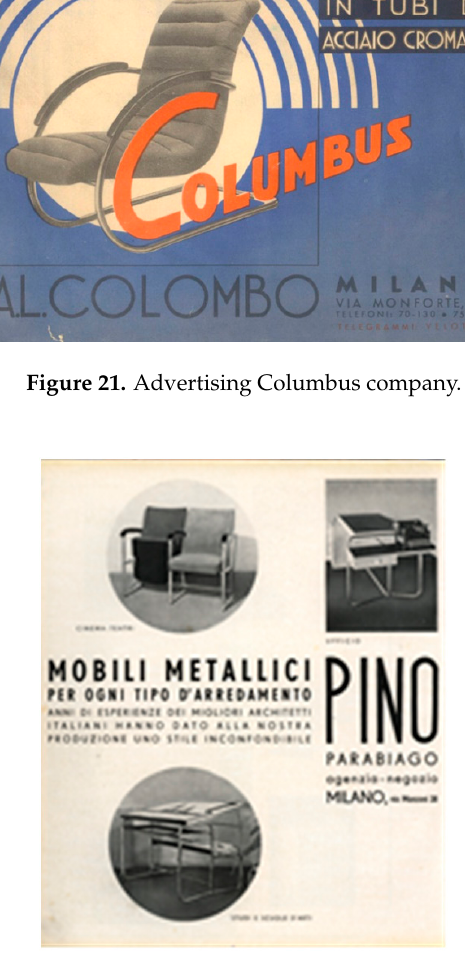
Figure 22. Advertising Pino Parabiago company.